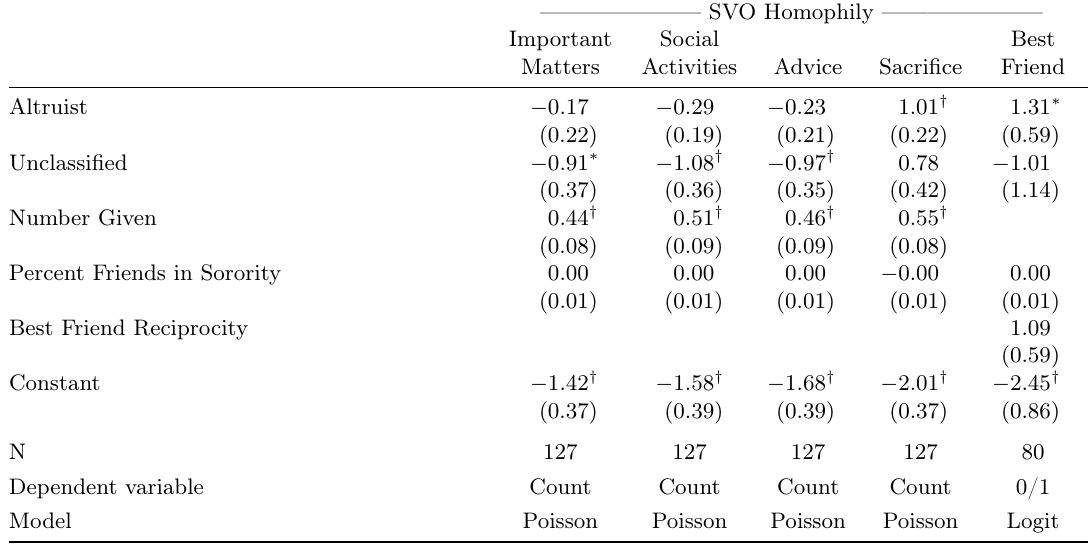
Table 2: Regression Estimates for Models Predicting Altruism Homophily Across Four Types of Close Relations in a Sorority (Study